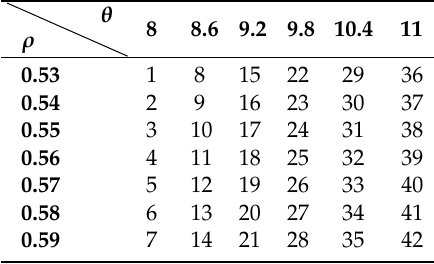
Table 3. Combinations of θ and ρ . The first row are the values for θ and the first column are the values for ρ . ρ